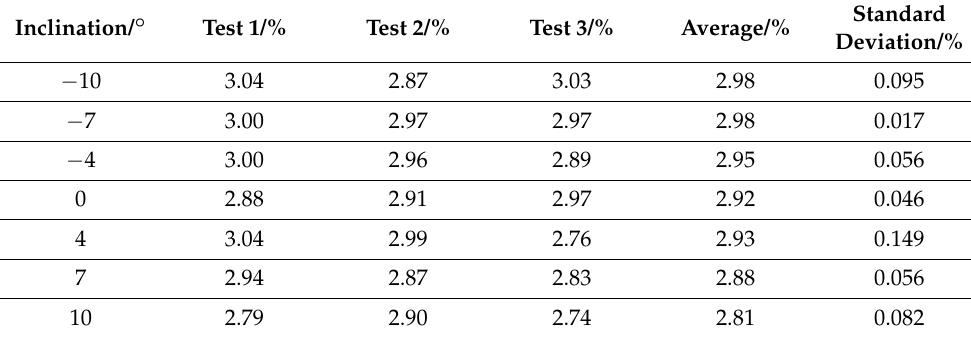
Table 8. Cleaning loss with automatic leveling control